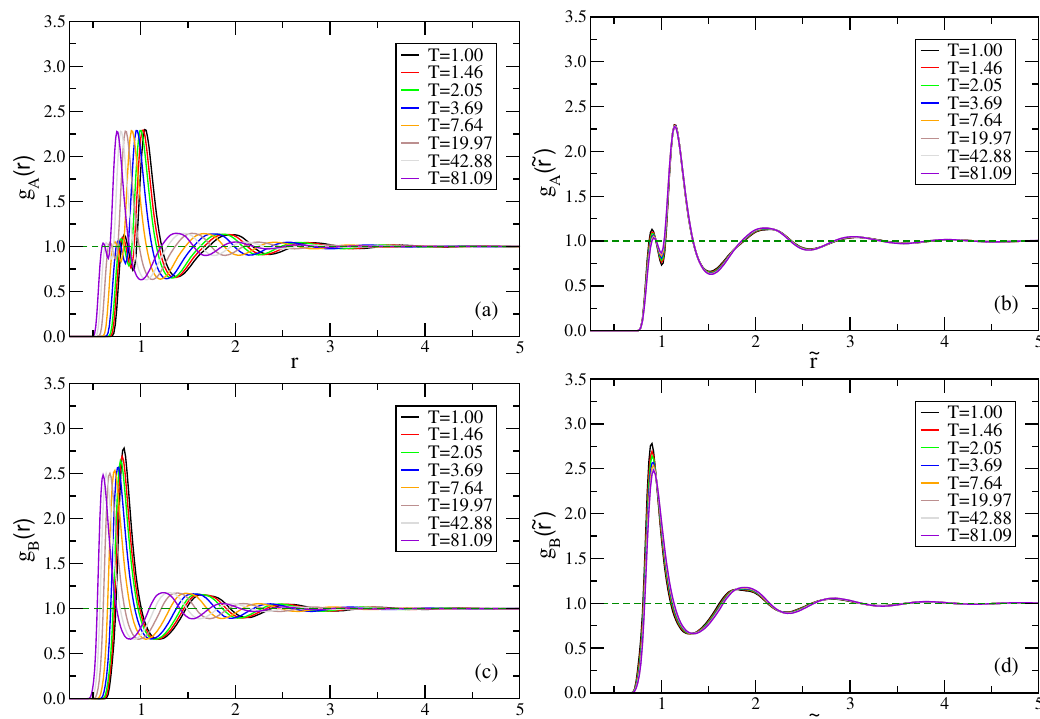
Figure 10. ( a – d ): RDF of central particles A or B counting all surrounding particles independent of their identity, monitored along the isomorph, plotted in both LJ units ( left ) and reduced units ( right ). There is good isomorph invariance of the reduced RDFs, although the first peak of the B particle RDF is visibly not isomorph invariant.